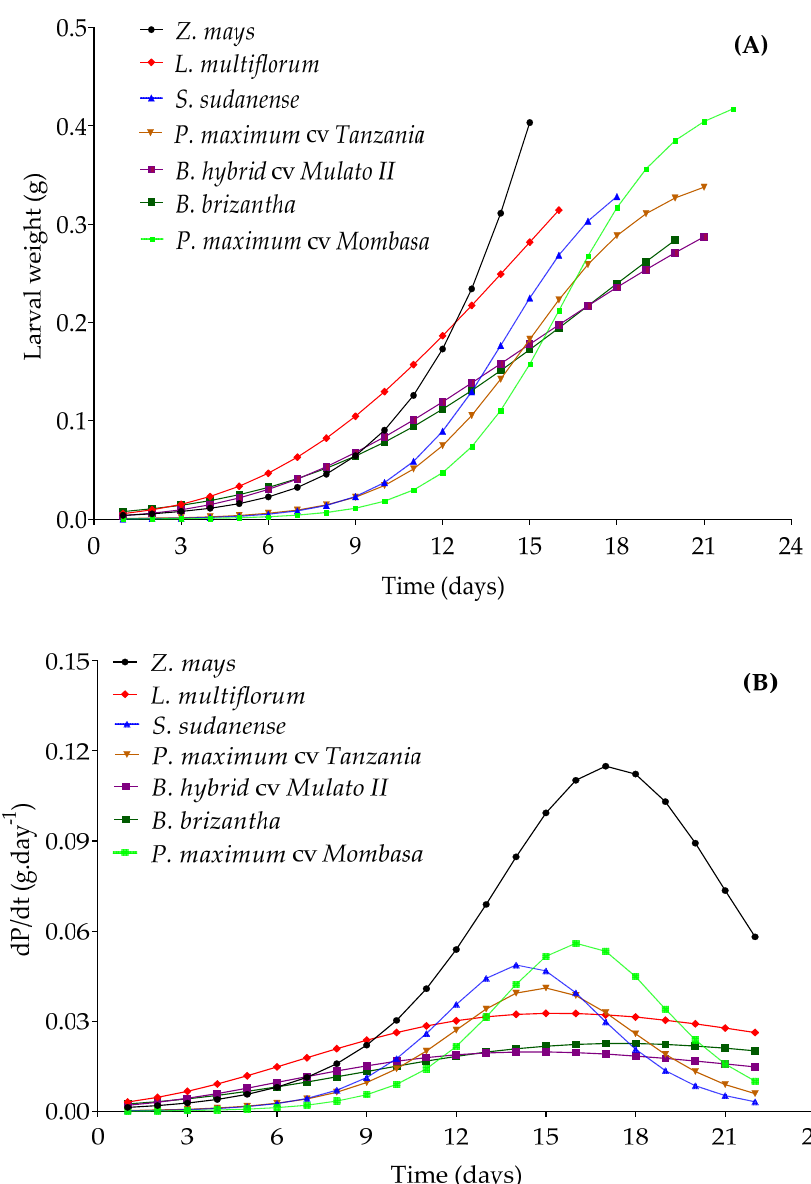
Figure 8. Growth curve ( A ) and growth rate ( B ) for S. frugiperda larvae weight in different grasses. Curves were compared at day 15. dP/dt = derivative of the weight growth function with respect to time, which represents larval weight growth rate.